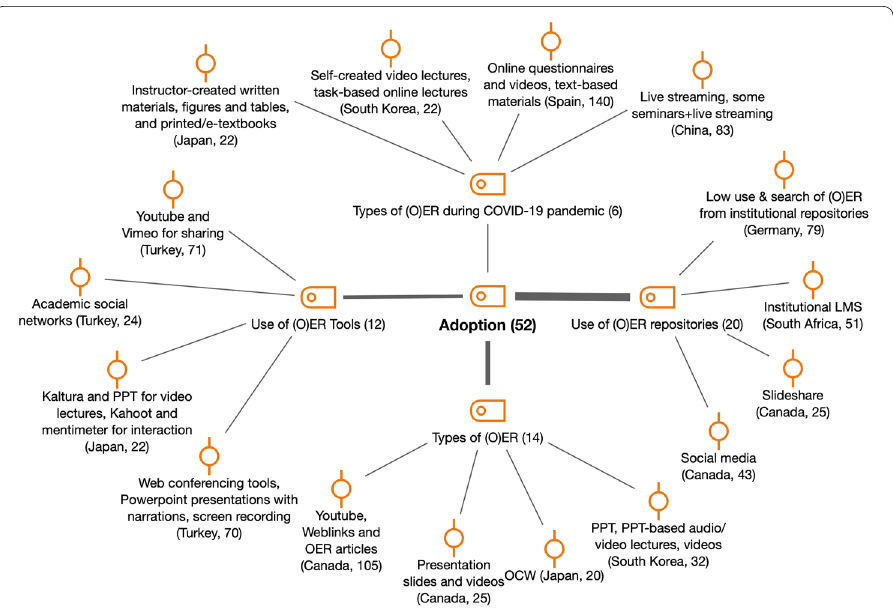
Fig. 4 Subcodes and examples for adoption (RQ1). Note Umbrella code (i.e., Adoption) is in the center and subcodes (e.g., Use of OER tools) are connected to it. The numbers between parentheses in codes and subcodes (also onwards on in n ) refer to the number of coded segments. Examples of those coded = segments have been included for each subcode, where the information in parentheses refers to the country report and the line number where that segment is located in the corresponding document. This note